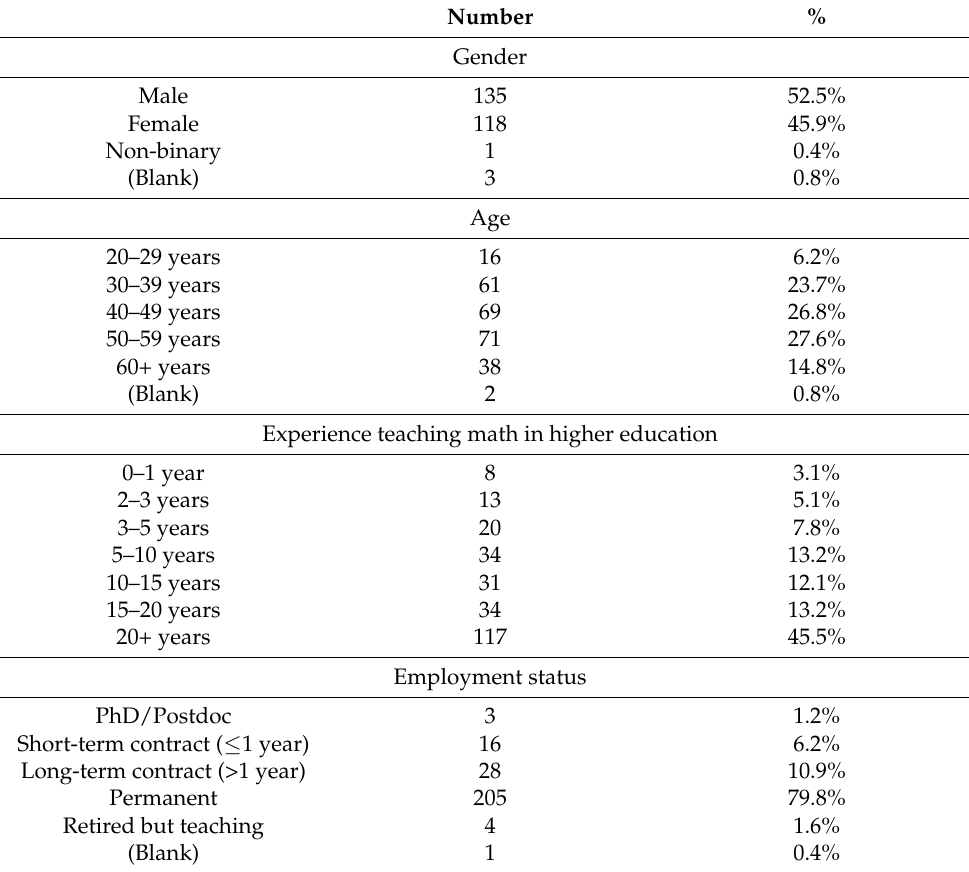
Table 1. Profile statistics of survey respondents ( n = 257), showing their gender, age, years of experience teaching mathematics in higher education, and current employment